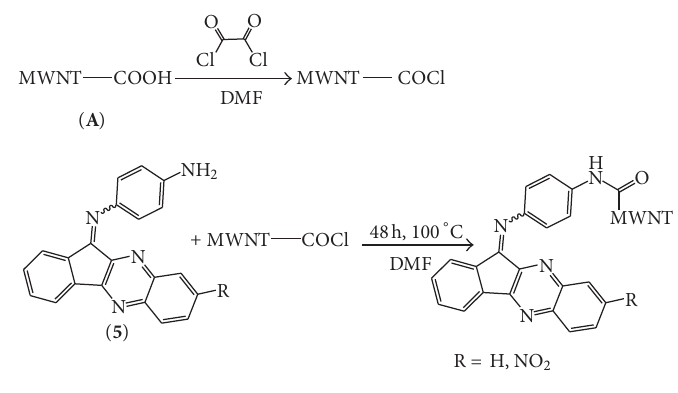
F 1: Synthesis route of modi�ed MWNT-COOH.